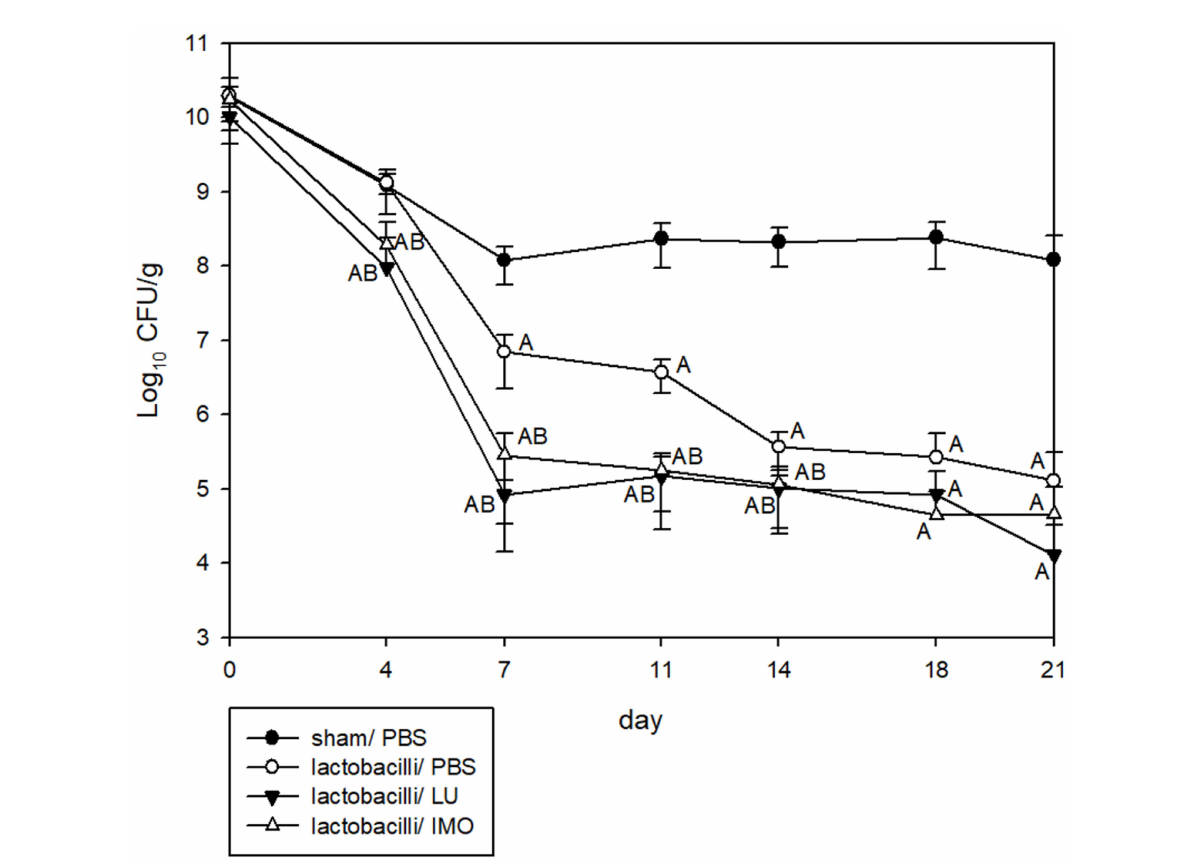
FIGURE 5 Kinetics of KPC001 from feces in three lactobacilli combined with PBS, lactulose or isomalto-oligosaccharide. Each symbol represents the mean ± SD of colony-forming units per gram (CFU/g) in feces from different treatment mice. (Group A: no lactobacilli or prebiotics, B: lactobacilli only, C: LYC1322, LYC1154, and LYC1511 with added LU, D: LYC1322, LYC1154, and LYC1511 with added IMO. LU: lactulose; IMO: isomalto- oligosaccharide. The letter indicates a significant difference compared with the indicated